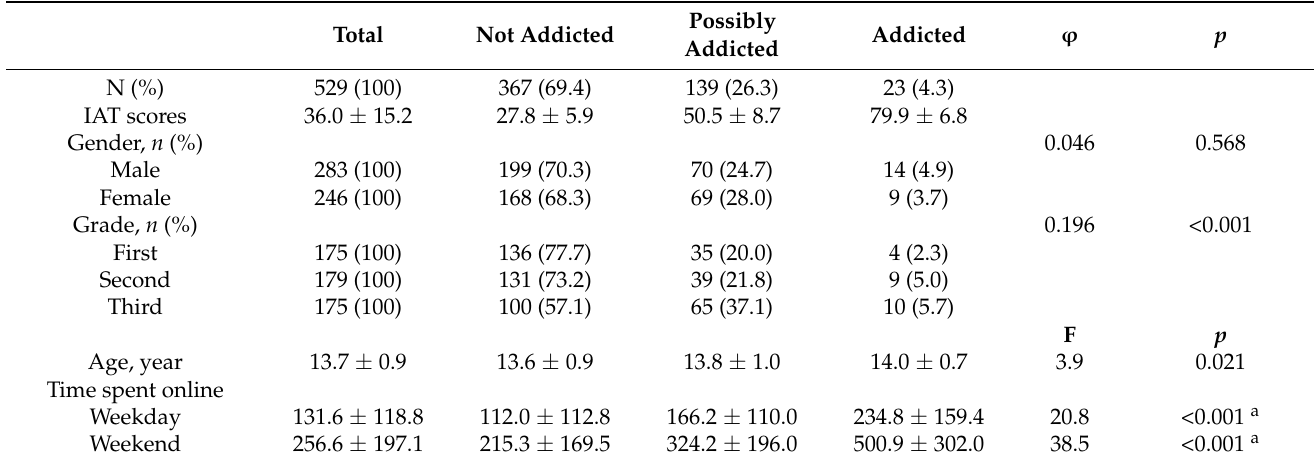
Table 1. Demographic characteristics of the participants.